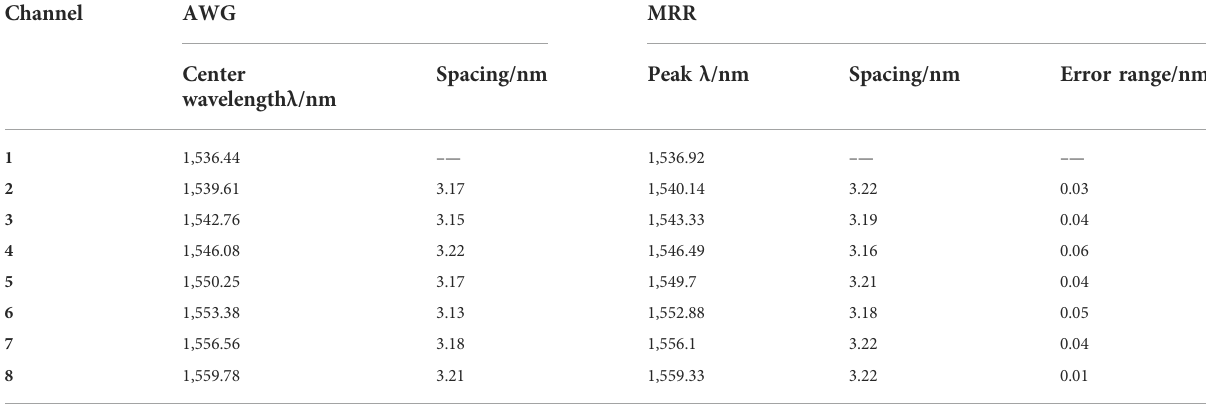
TABLE 4 Measured FSR of MRR4 and channel spacing of AWG.